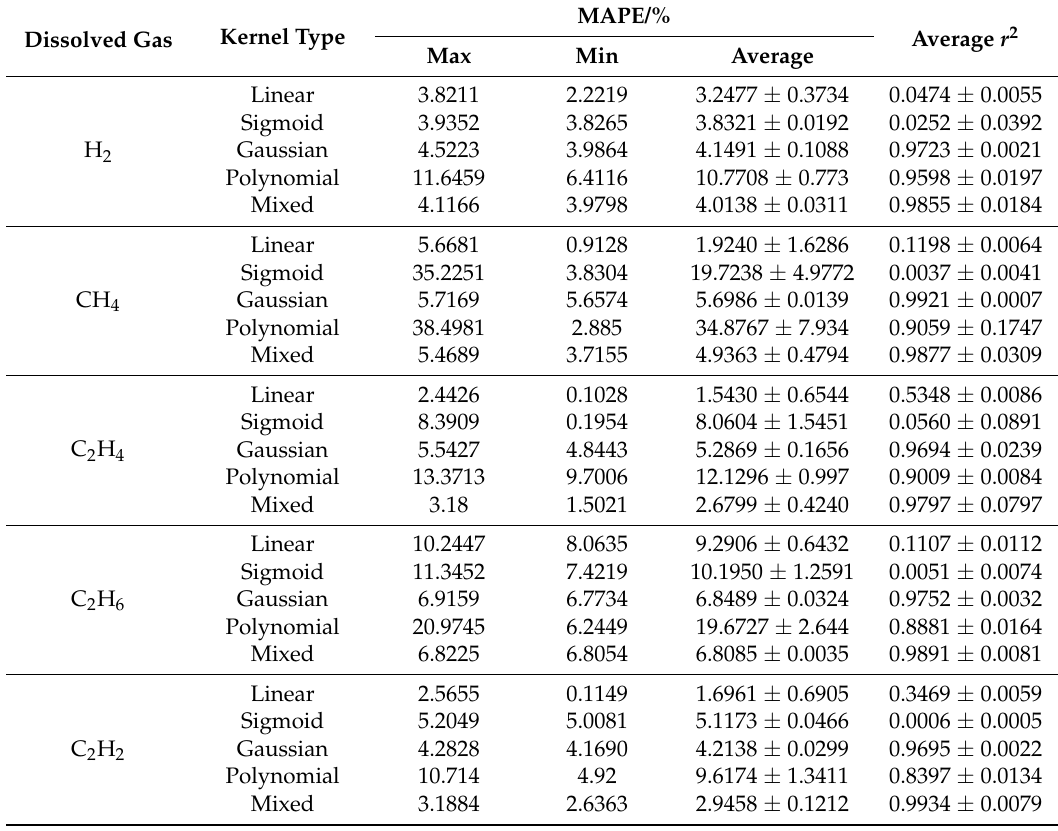
Table 4. The average forecasting performance of the training set (Case 2, 50